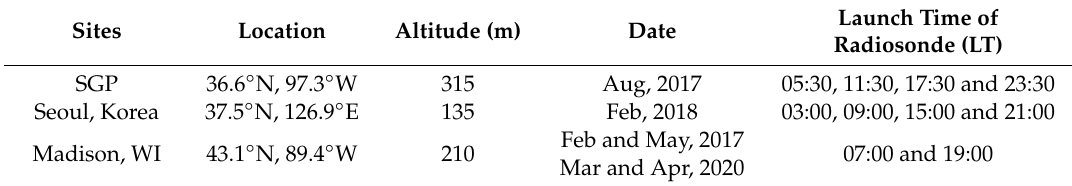
Table 1. Descriptions of the three sites with lidar date and fine-resolution sounding profiles.